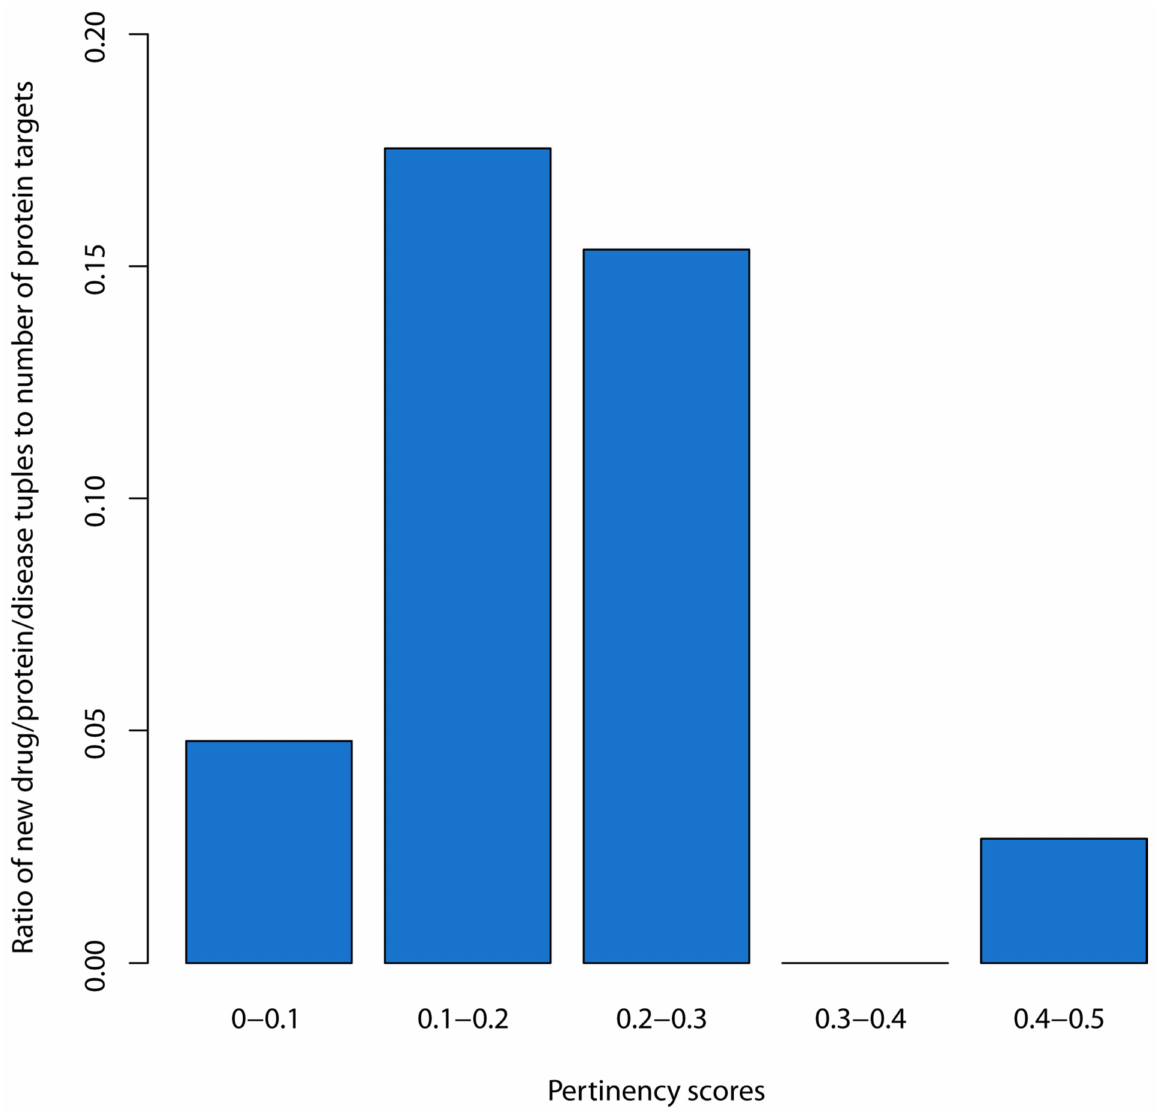
Figure 3. Bar chart of the ratio of the number of drug/protein/disease tuples to the number of proteins targets for each pertinency score